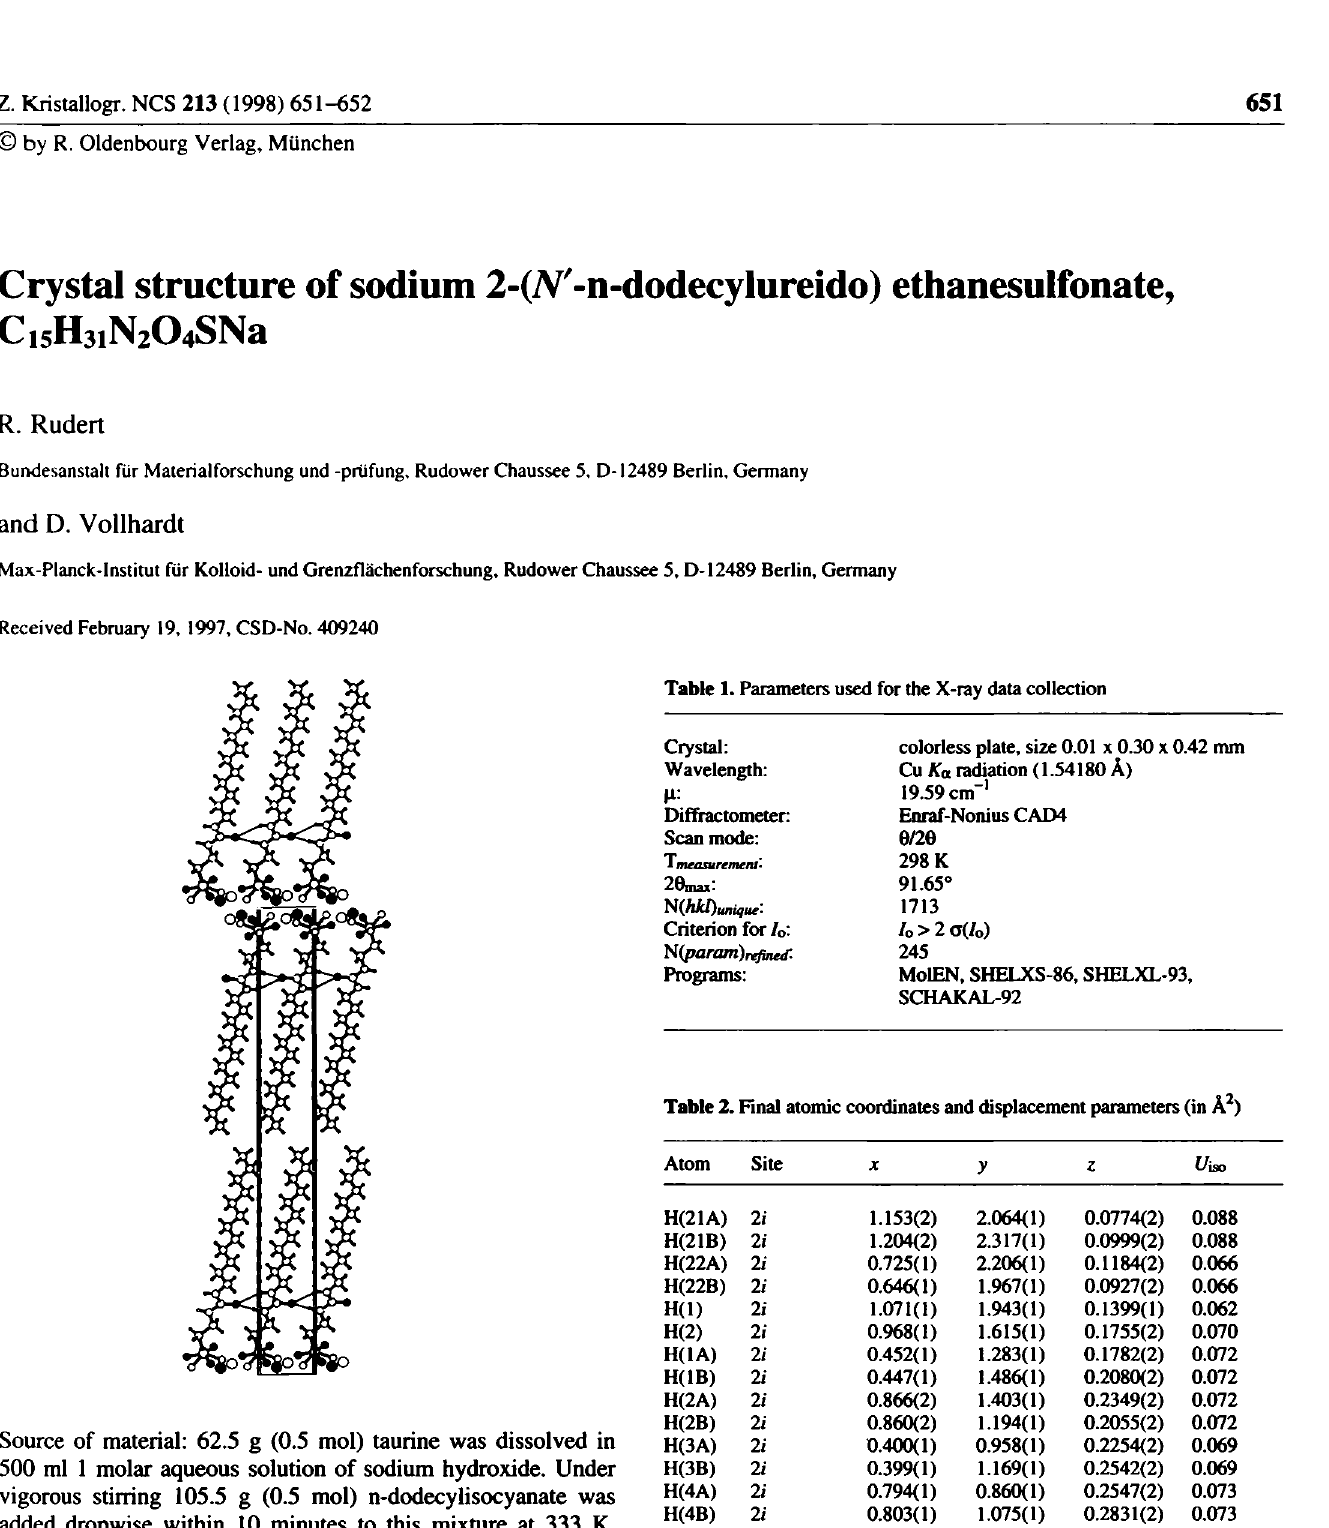
Table 1. Parameters used for the X-ray data collection